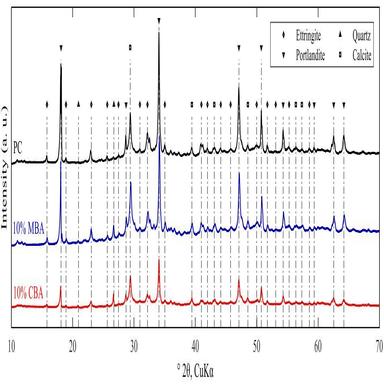
XRD patterns of trail mixtures at the age of 28 days.